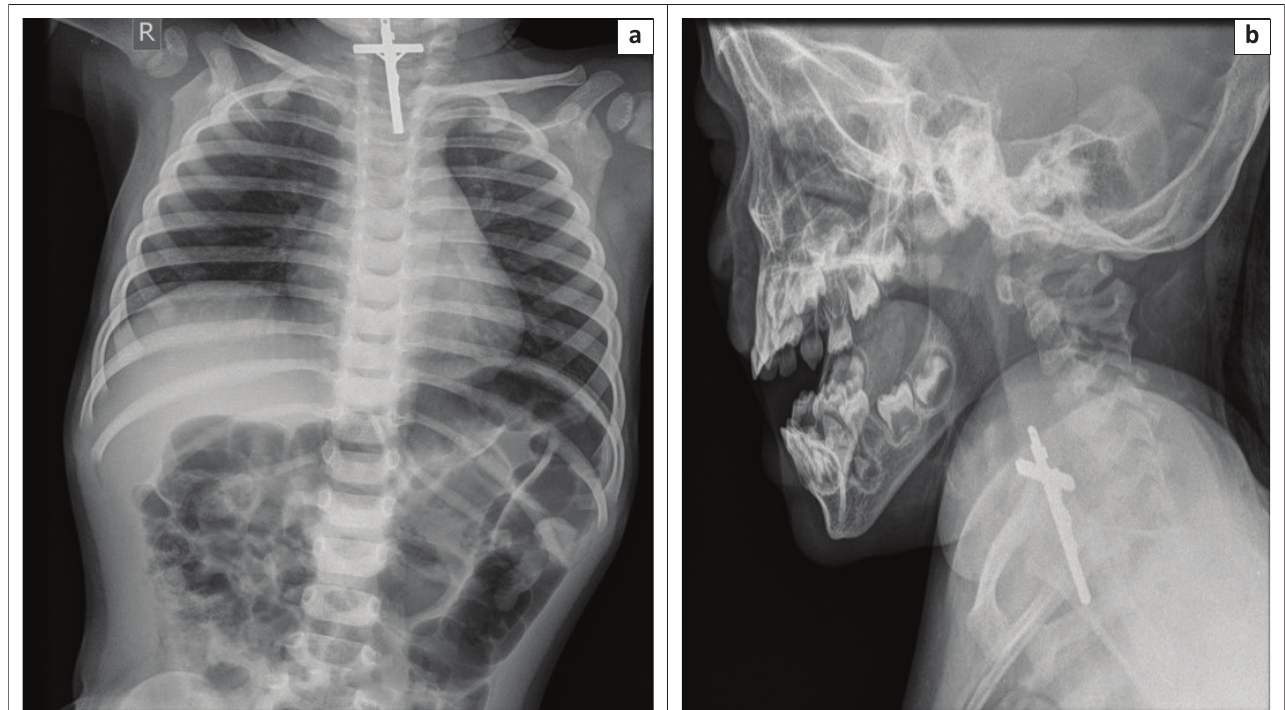
FIGURE 8: Frontal (a) and lateral (b) radiographs of the neck indicates a crucifix impacted in the cervical oesophagus of a 2-year-old child. The foreign body was retrieved by rigid